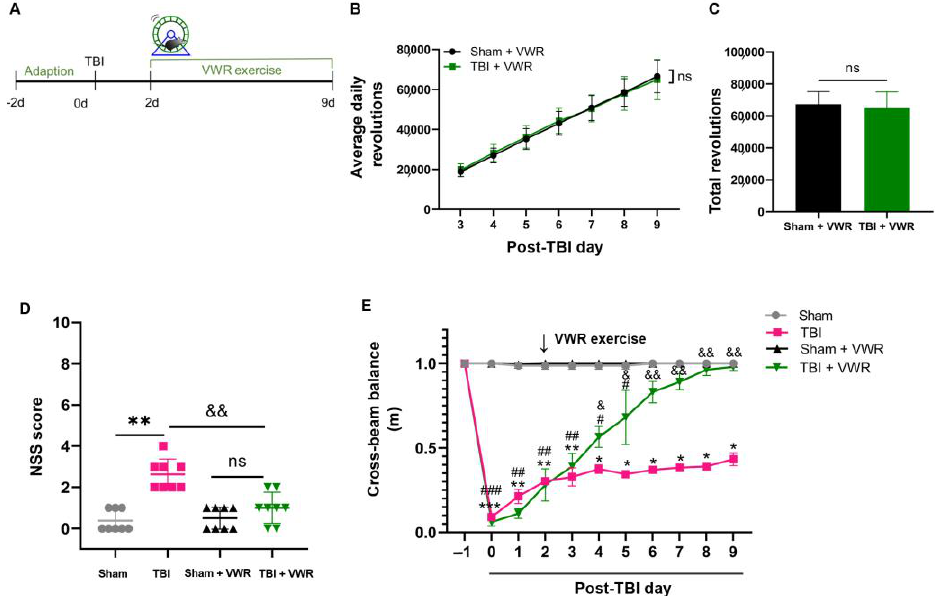
Figure 1. VWR improved sensorimotor coordination and balance in TBI mice. ( A ) The diagrammatic sketch of experimental design and VWR strategy. ( B ) There was no significant difference in daily running wheel revolutions between TBI and Sham groups. Two-way ANOVA, post hoc Tukey’s multiple comparisons tests; n = 7. ( C ) No significant difference was found in total running wheel revolutions between TBI and Sham groups. Unpaired student’s t-test; n = 7. ( D ) TBI-induced elevation of NSS significantly reduced after seven days of VWR. One-way ANOVA, post hoc Sidak’s multiple comparisons tests; n = 12. ( E ) TBI caused a significant reduction in beam walking distance increased gradually during VWR. Two-way ANOVA, post hoc Tukey’s multiple comparisons tests; n = 6). *** p < 0.0001, ** p < 0.001, * p < 0.01, vs. Sham. & p < 0.01, && p < 0.001 vs. TBI. ### p < 0.0001, ## p < 0.001, # p < 0.01 vs. Sham + VWR. ns, no significance. VWR, voluntary wheel running; TBI, traumatic brain injury; NSS, neurological severity